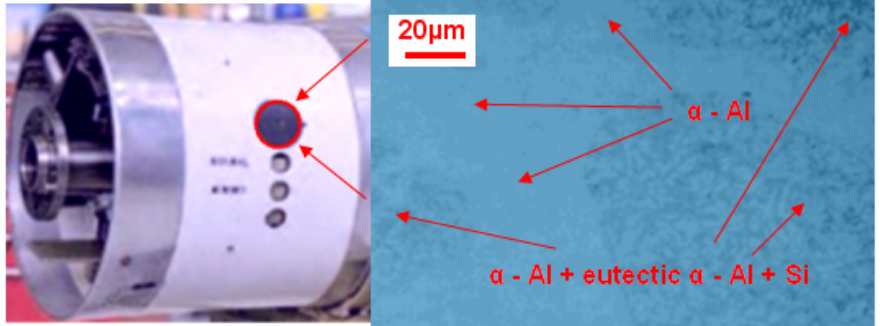
Figure 5 – Oil tank of the ASTAZOU III B turbojet engine and the microstructure of the Al12Si coating Рис . 5 – Масляный резервуар турбореактивного двигателя ASTAZOU III B и микроструктура покрытия Al12Si prevlake